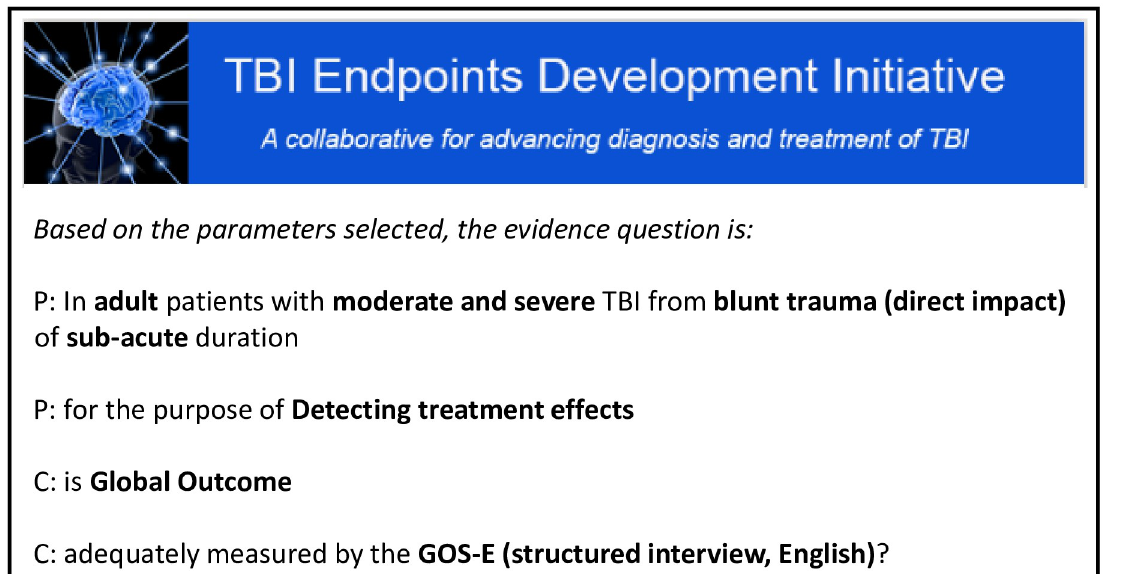
Fig 3. Screenshot of the evidence question generated by the EB-COP. The evidence question describes the context of use for which the COA will be tested. Contextual factors include descriptive characteristics of the sample, the chronicity of the condition, the purpose for which the COA has been selected and the concept of interest the COA purports to